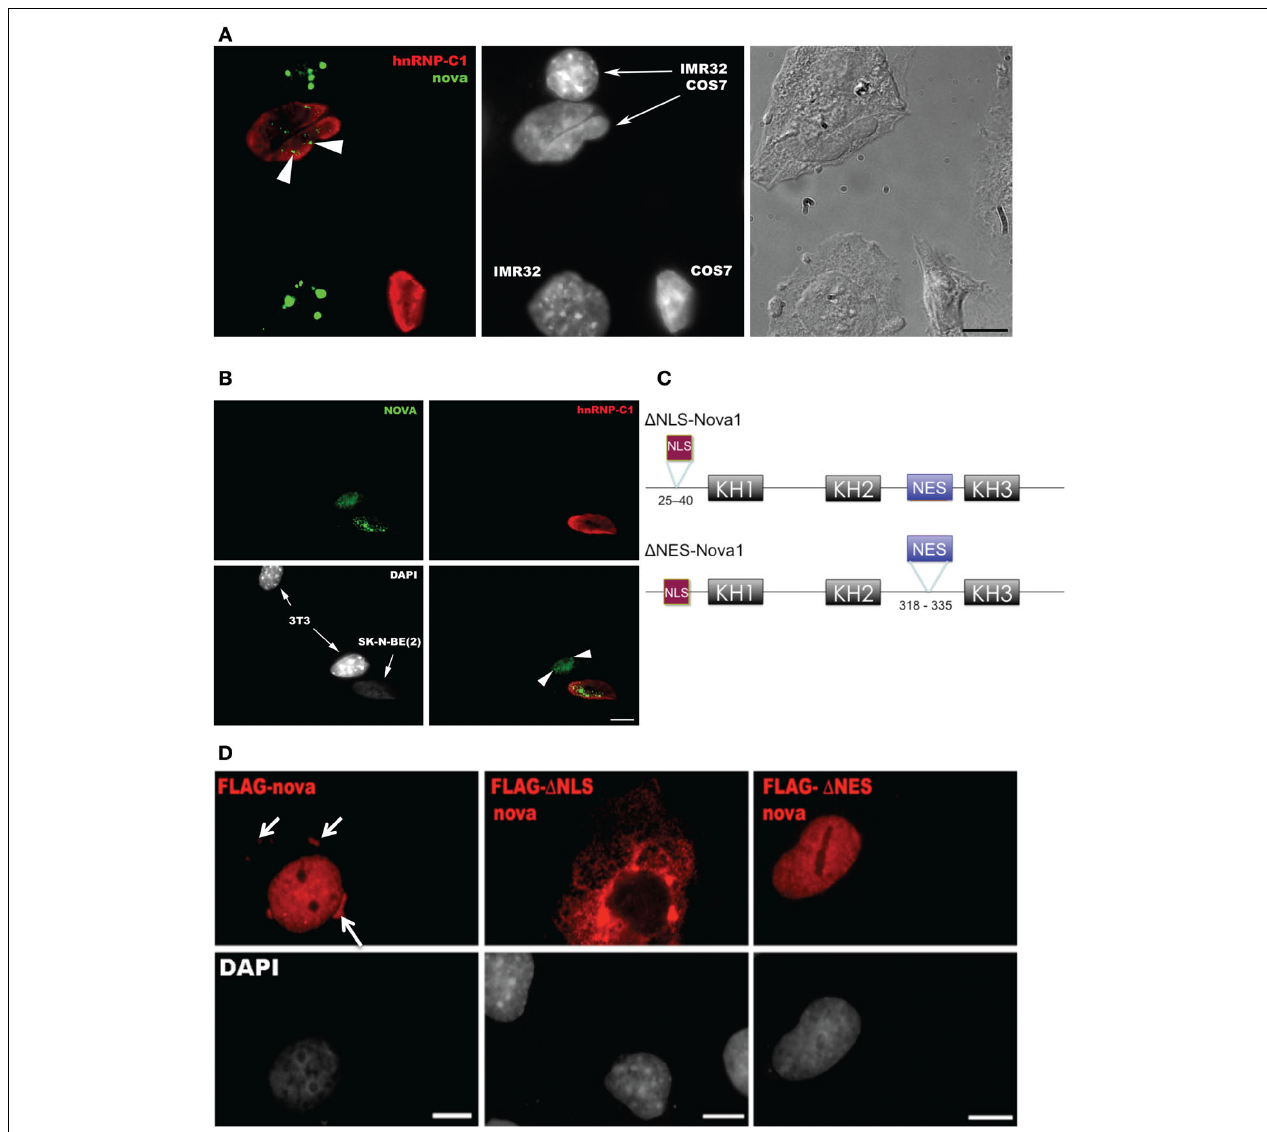
FIGURE 2 | Nova proteins shuttle between the nucleus and cytoplasm. (A) IMR32 and COS7 cells were fused with PEG 3350, and anti-hnRNPC1 and anti-Nova antibodies were used to detect endogenous proteins. In this fi eld one cell has been fused with COS7 (top; see phase contrast, right panel), and two unfused cells are evident (bottom); cell types can be distinguished with DAPI staining (middle panel). Nova proteins were detected in IMR32 and fused COS7 cells (arrowheads), but no signal in isolated COS7 cells. DAPI staining showed IMR32 cells and COS7 cells, respectively. (B) Shuttling of endogenous Nova from